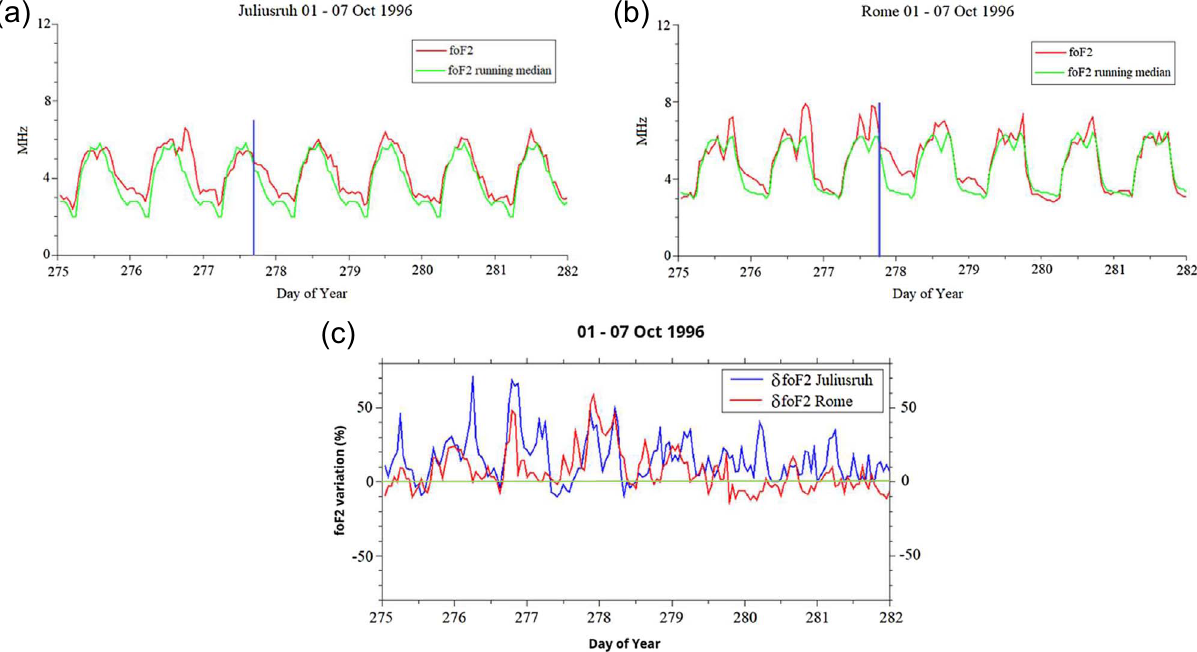
Fig. 11. In panel (a), the red line represents the hourly values of foF2, recorded at Juliusruh ionospheric station from 01 to 07 October 1996. The green line represents the foF2 running median here considered as background value of the ionospheric parameter. In panel (b) the same parameters, recorded by the Rome ionospheric station, are reported, considering the same time period. In panel (c) is reported the variation in percentage of the foF2 for the two ionospheric stations, for the considered period.